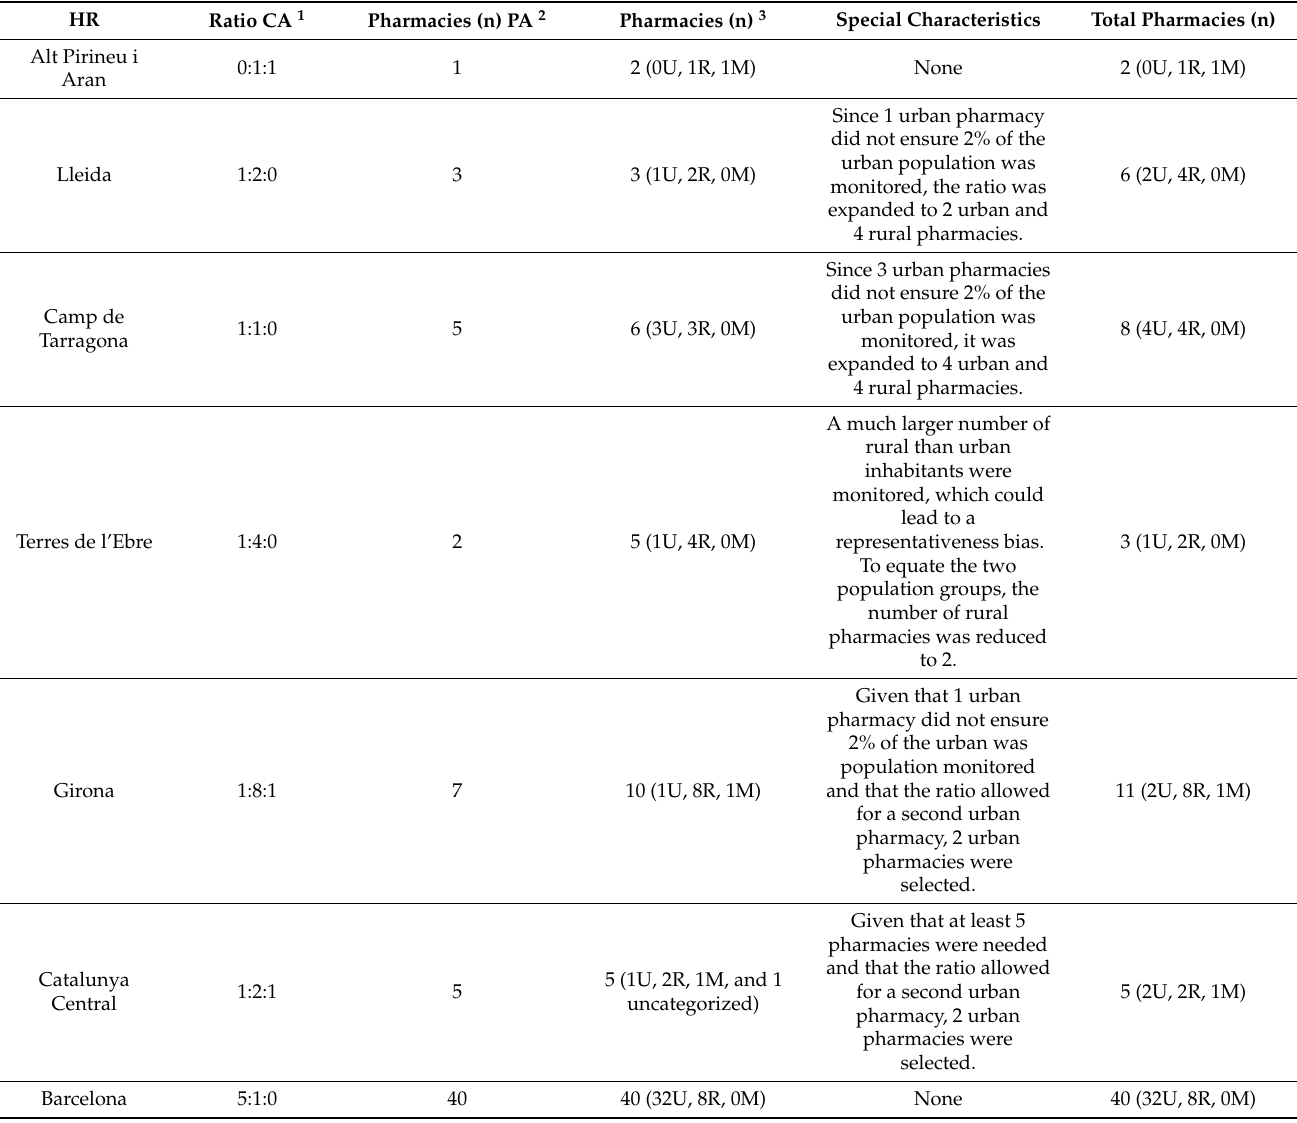
Table 3. Population analysis to obtain the minimum number of pharmacies per